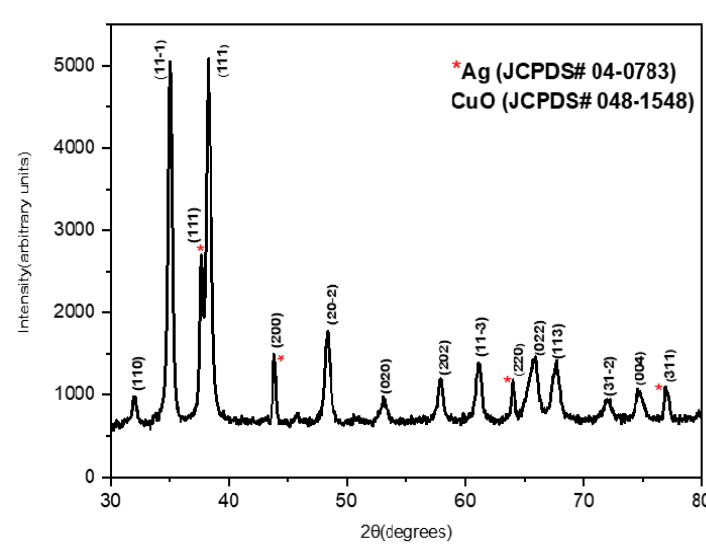
Figure 2. XRD spectrum of Ag-CuO NPs (* represents Ag peaks) .